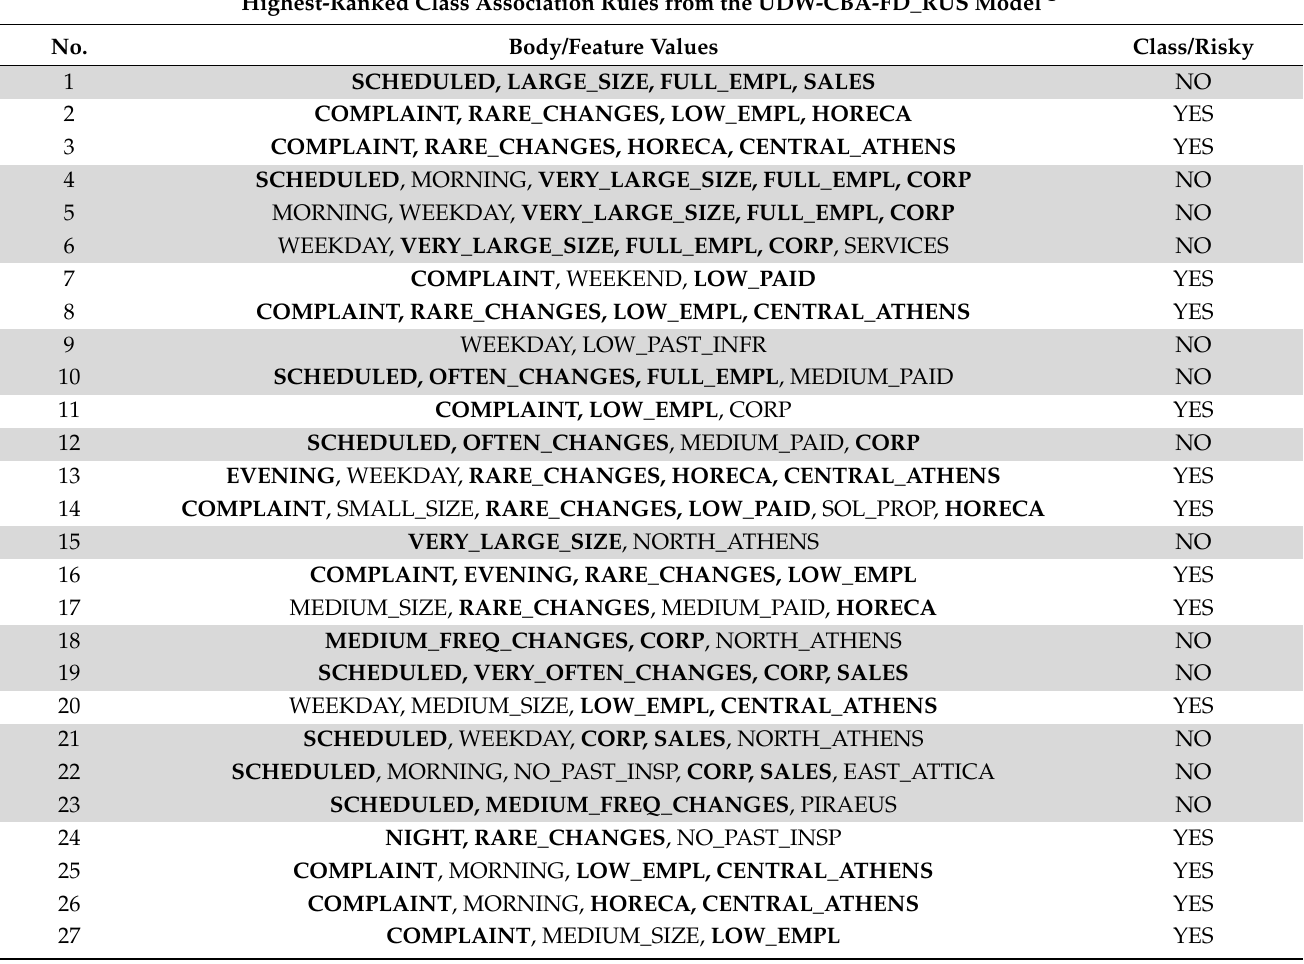
Table 13. Prevailing patterns of compliance and non-compliance as regards undeclared